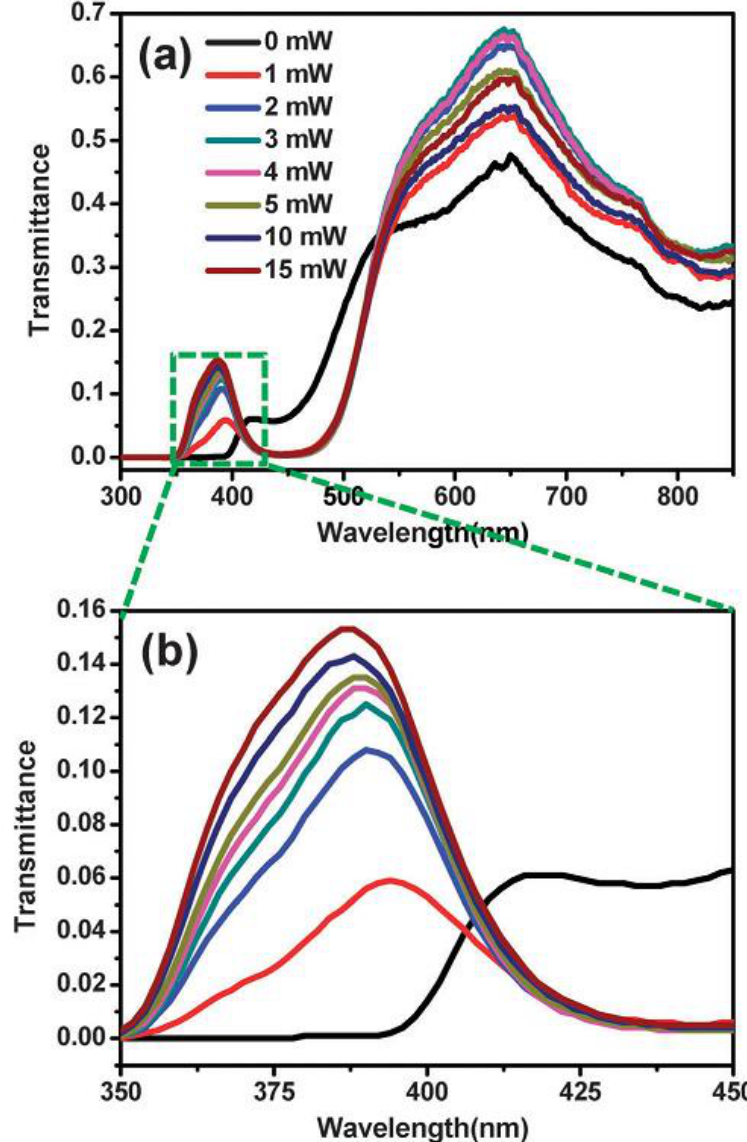
Figure 5. ( a ) Measured transmittance of silver nanorods covered by LCs as a function of wavelength for varying pumping power at 20° incidence angle and ( b ) enlarged view of 350 nm to 450 nm wavelengths showing more details of resonances located at 380–390 nm. Reproduced with permission from [102]. Copyright Royal Society of Chemistry, 2015.